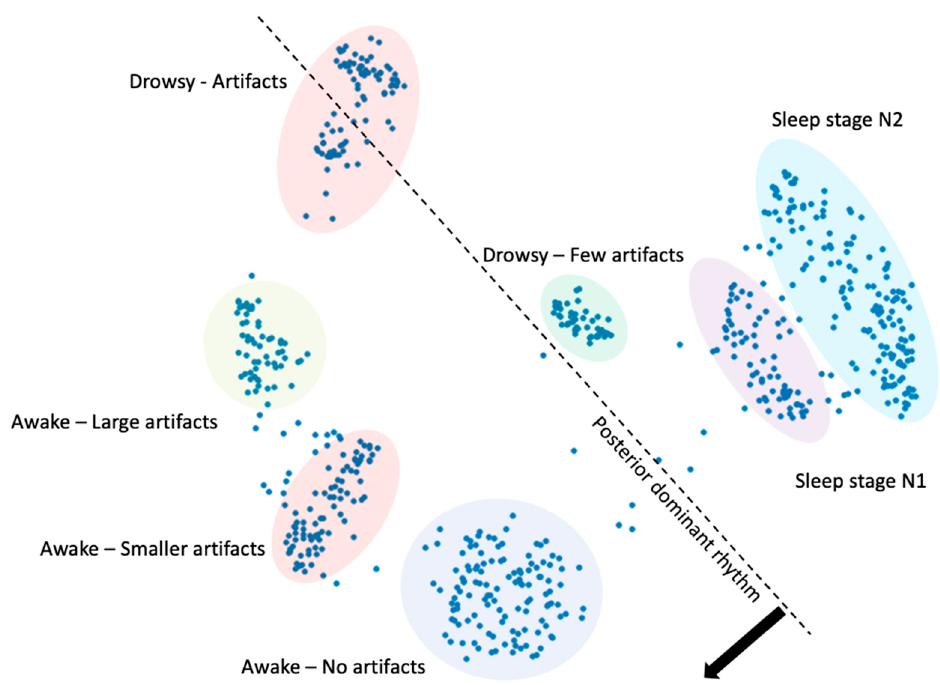
Figure 1. Low-dimensional representation of a 21-channel EEG with a 22 min duration, where each dot represents 2 s of EEG. The figure was generated by a convolutional neural network trained using the principle described in this article, which is based on t-SNE. With a sampling frequency of 250 Hz for the raw EEG, this represents a reduction from 6,930,000 to 1320 data values. A comparison with the original EEG was conducted, and based on this, the structure of the low-dimensional representation is indicated in the figure. The comparison was carried out by visually inspecting the EEG segments corresponding to the dots and characterizing each cluster. The dashed line indicates a boundary, where a posterior-dominant rhythm was present in EEG segments corresponding to the dots to the left of the line.